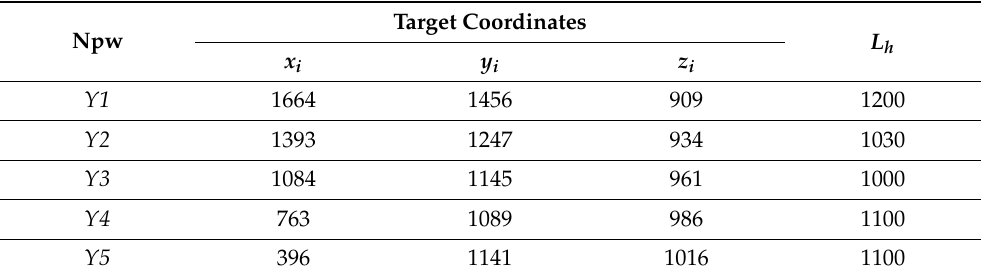
Table 2. Y well group drilling design.